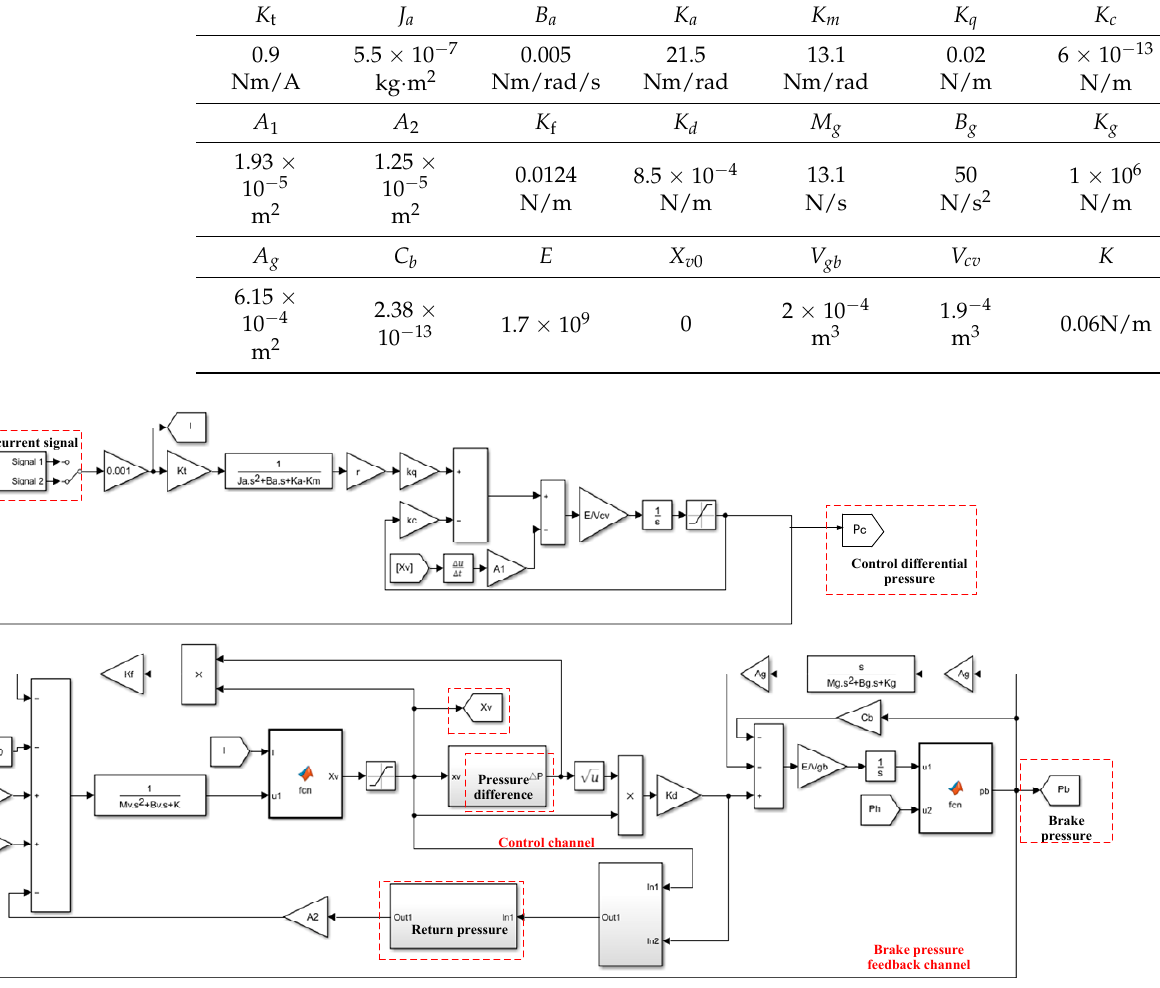
Table 1. Simulation parameter value.